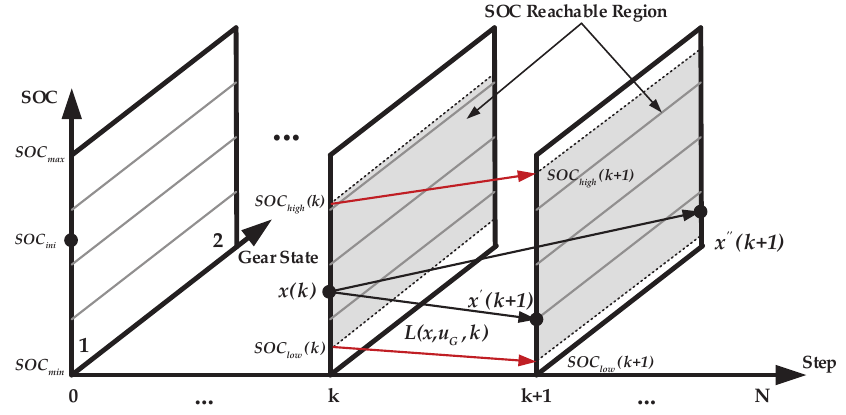
Figure 4. Determine the SOC reachable region during the Dynamic Programming (DP) calculation